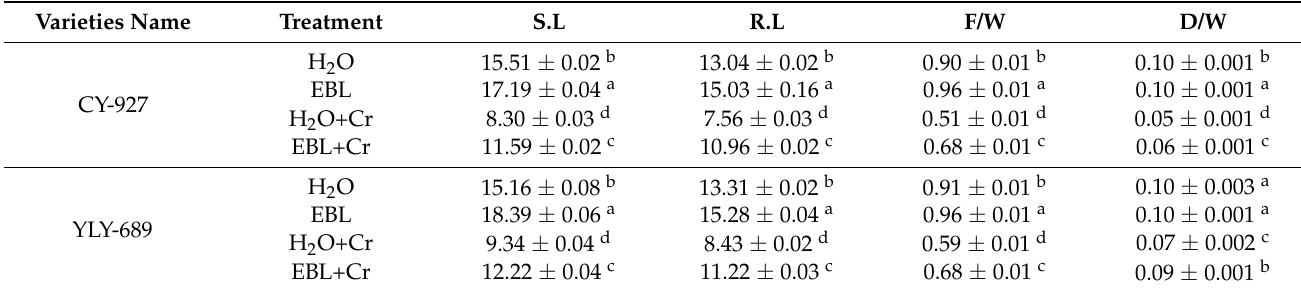
Table 2. Improvement in shoot length, root length, and fresh and dry weight by seed priming with EBL compared to the control under Cr